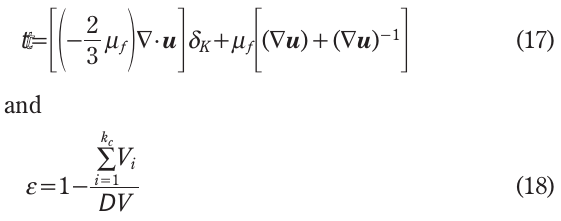
Table 1 Parameters used for the present simulation *